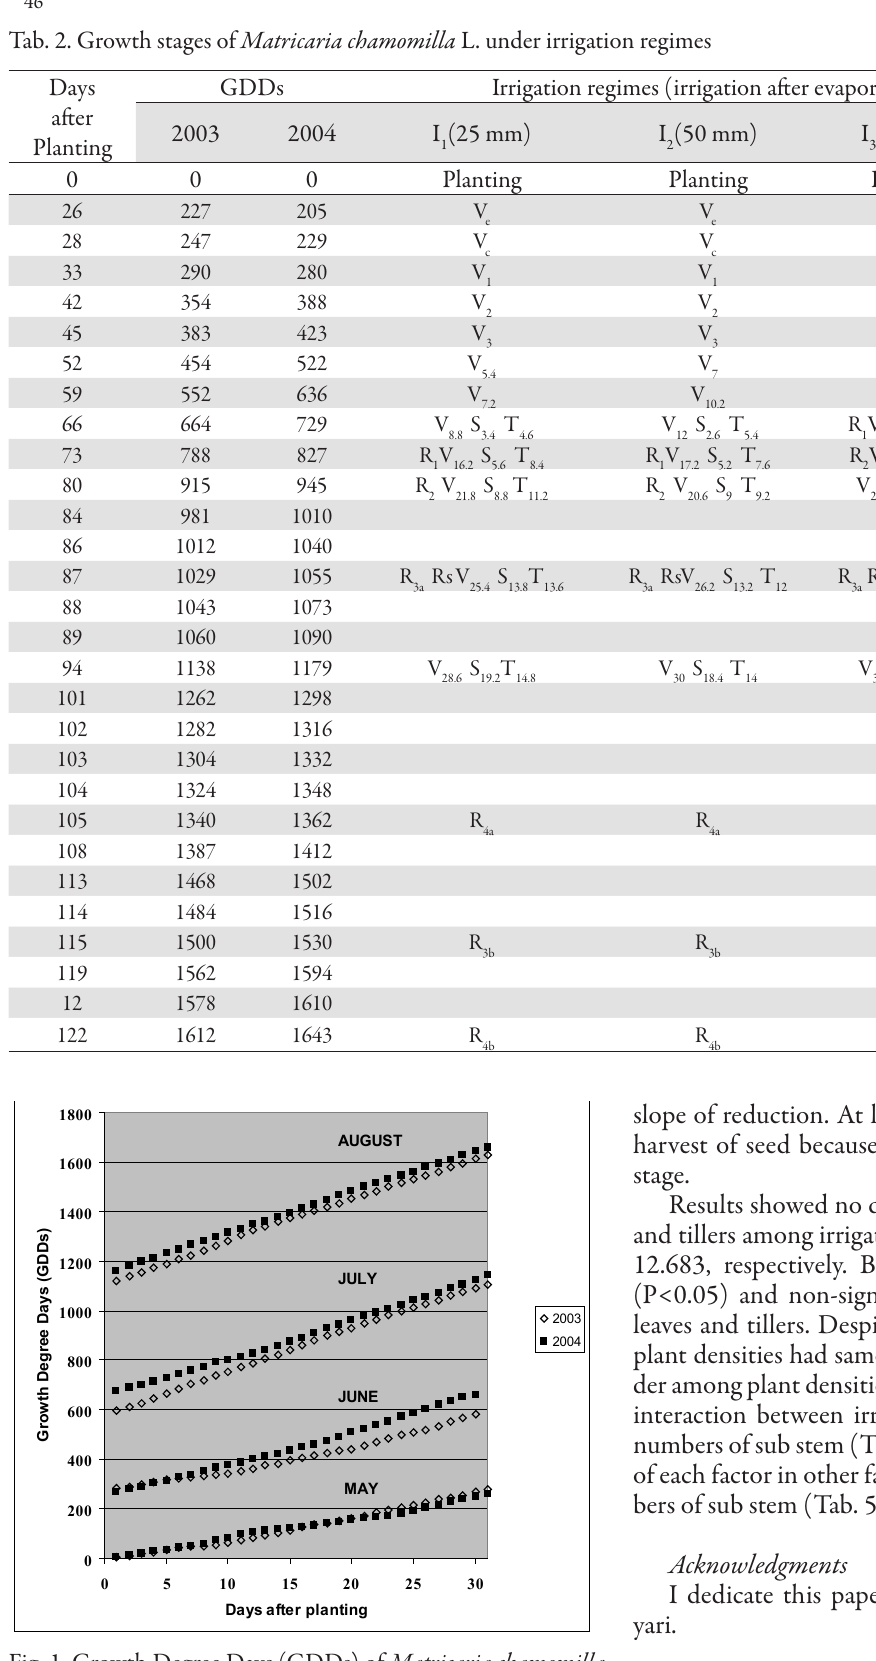
Fig. 1. Growth Degree Days (GDDs) of Matricaria chamomilla L. at the experiment